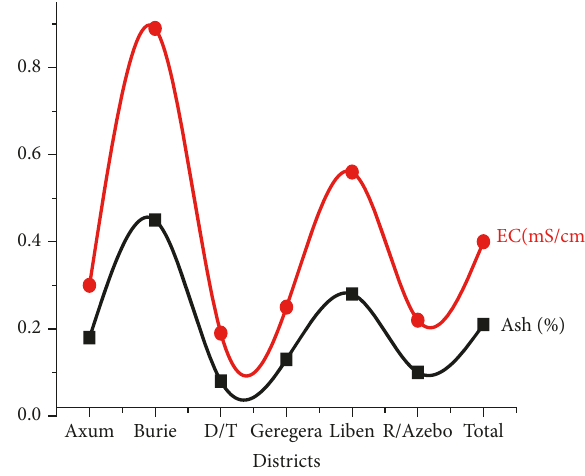
Figure 2: Relationship between ash content and EC values of the studied honey